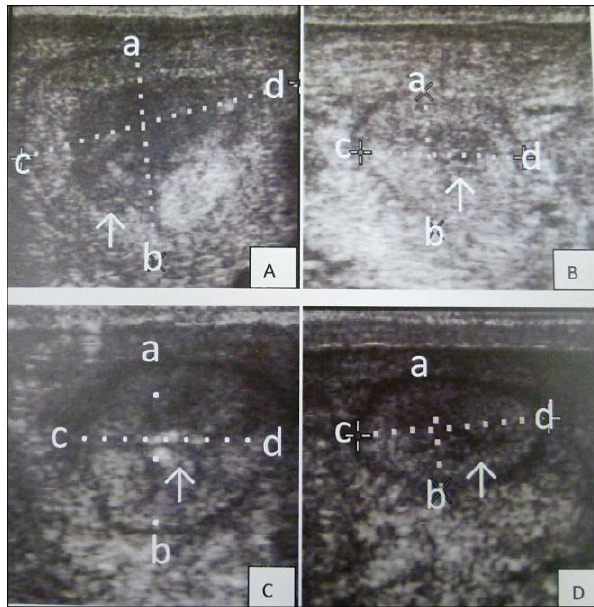
Figure 4. Ultrasonogram of intrauterine fluid volumes in postpartum cows treated with Sheng Hua Tang. The intrauterine fluid volumes were scored in a 0 to 3 scale: 0 represents no fluid and 1 to 3 represent the increasing fluid volumes in the uterine horns. Indicates a-b-c-d regarding the scope is the endometrium, the arrow for the intrauterine fluid; A: In massive intrauterine fluid, score = 3; B: In quantity intrauterine fluid, score = 2; C: In few intrauterine fluid, score = 1; D: None intrauterine fluid, score =